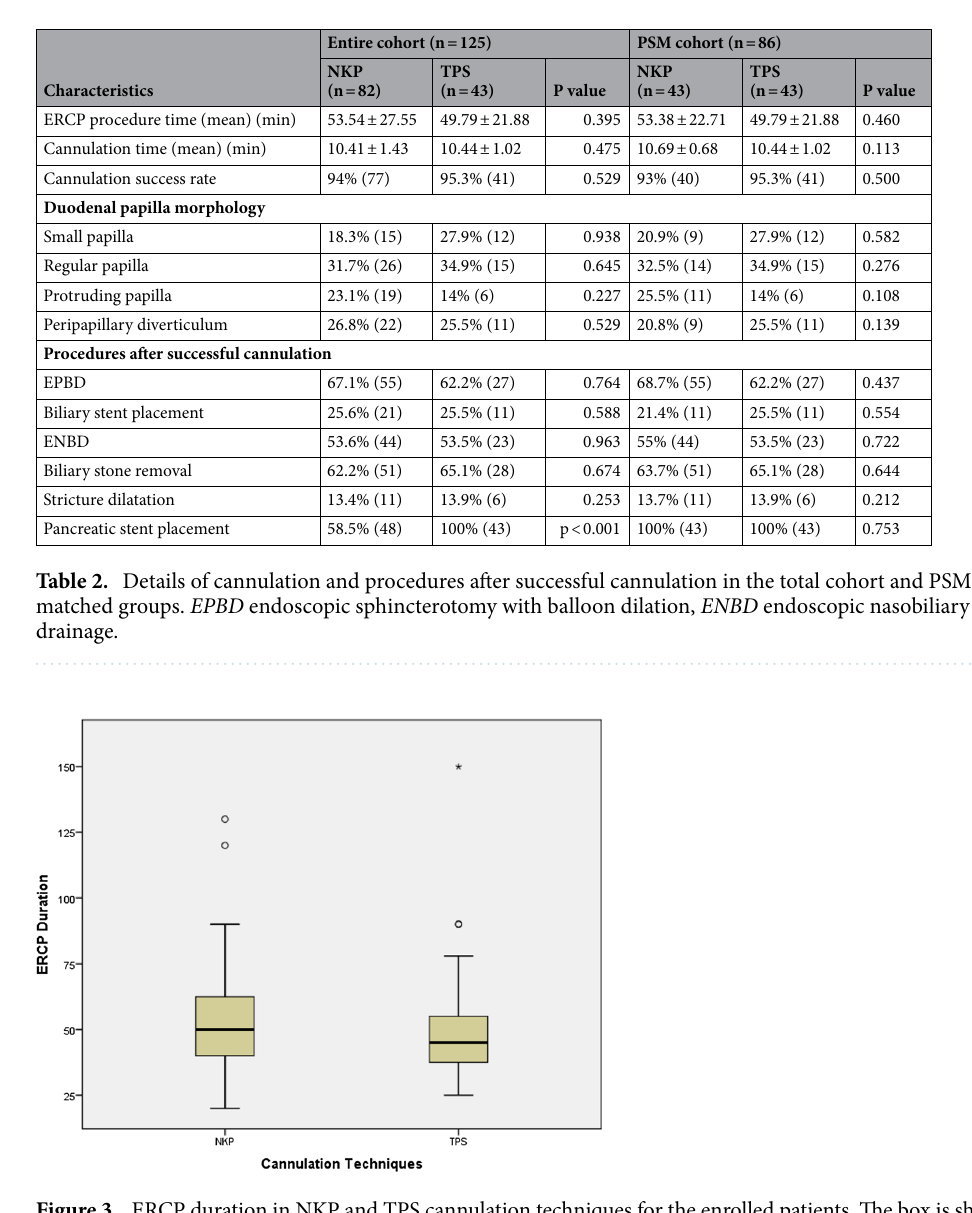
Figure 3. ERCP duration in NKP and TPS cannulation techniques for the enrolled patients. The box is shorter for TPS than NKP. The inner fences extend less for TPS compared to NKP. That is, the procedure time varies less for TPS than for NKP.